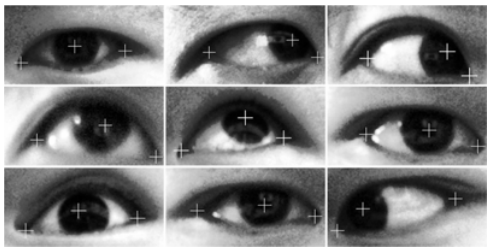
Figure 5: Results of successful eye corners detection on eye database.